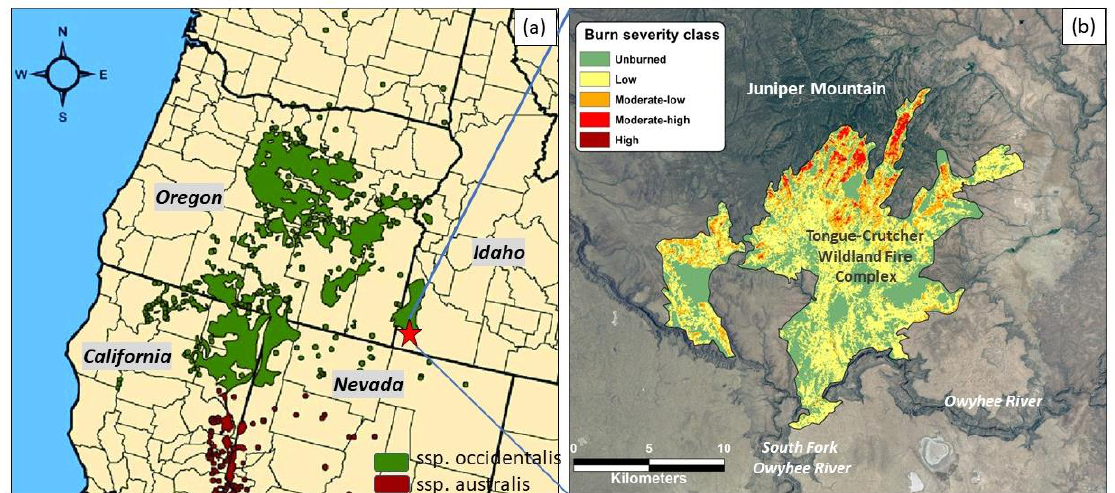
Figure 2. ( a ) Distribution of western juniper in the western United States. ( b ) Location of the 2007 Tongue-Crutcher Wildland Fire Complex on Juniper Mountain including burn severity classes within the fire perimeter.